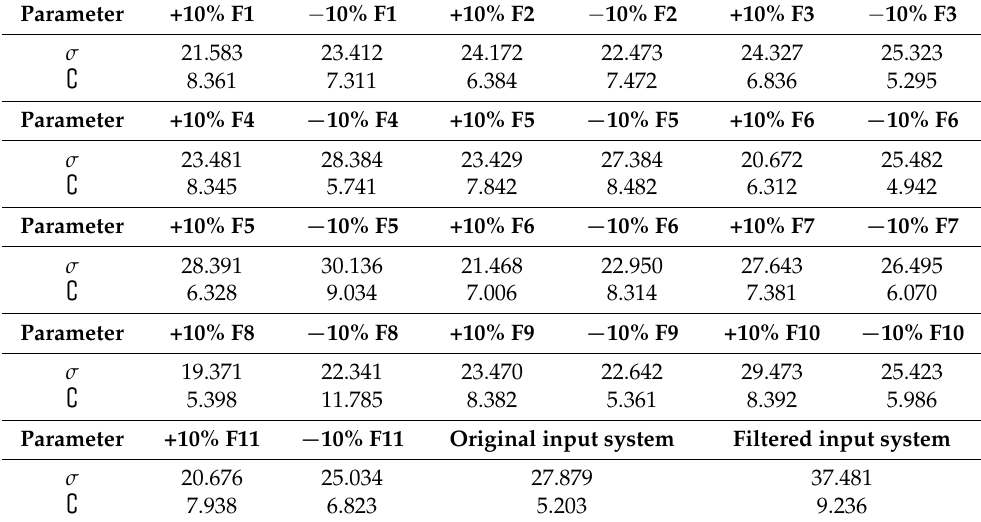
Table 9. Optimal parameter combination of the LSSVM.